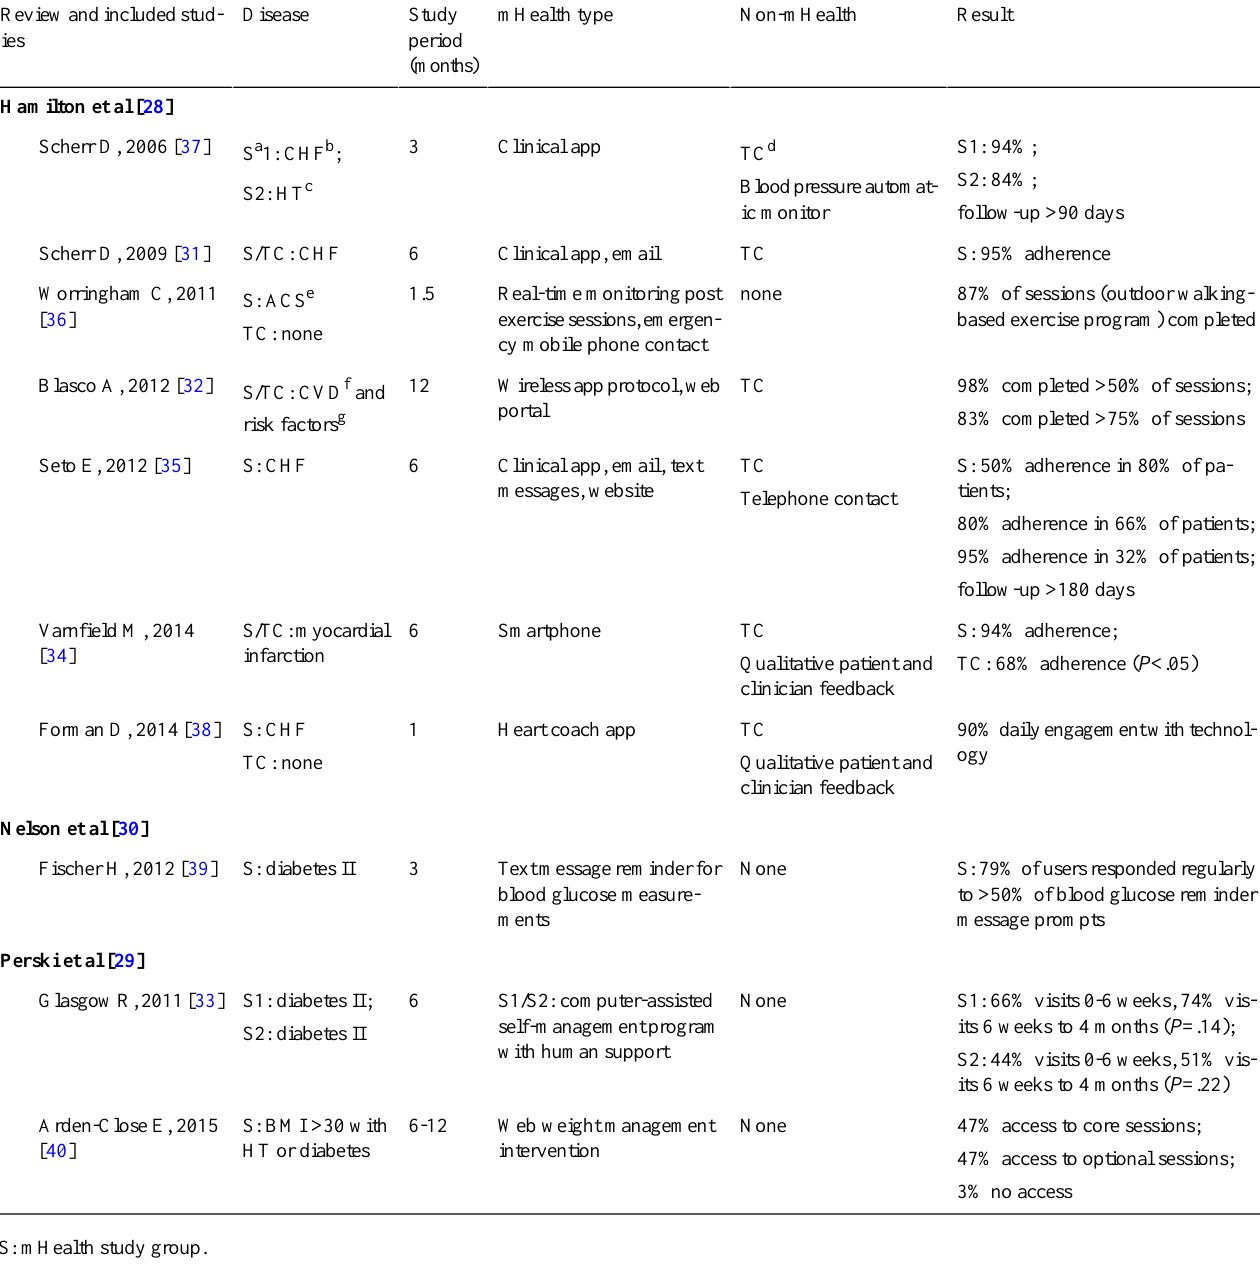
Table 3. Outcomes of engagement using mHealth